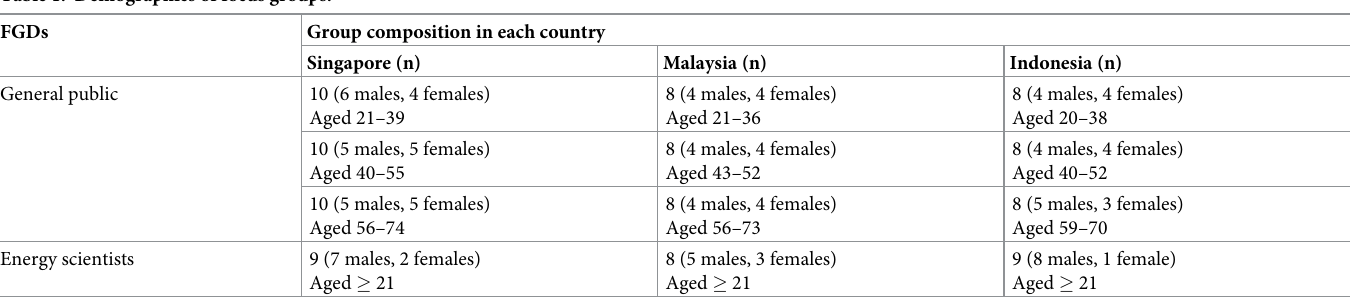
Table 1. Demographics of focus groups. FGDs